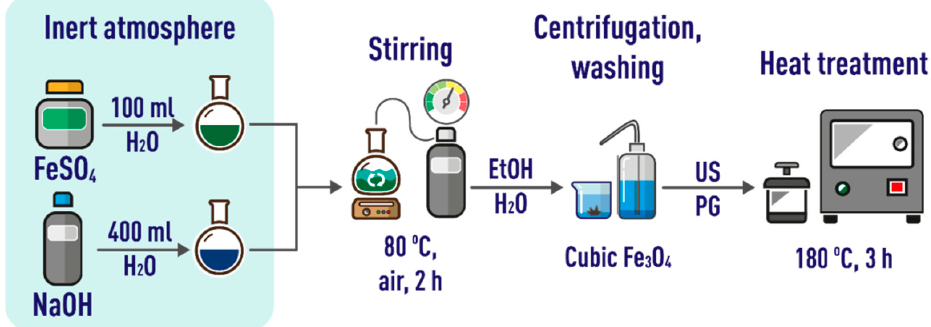
Figure 10. A workflow for obtaining nanoparticles of cubic magnetite. US = ultrasound; PG = propylene glycol.